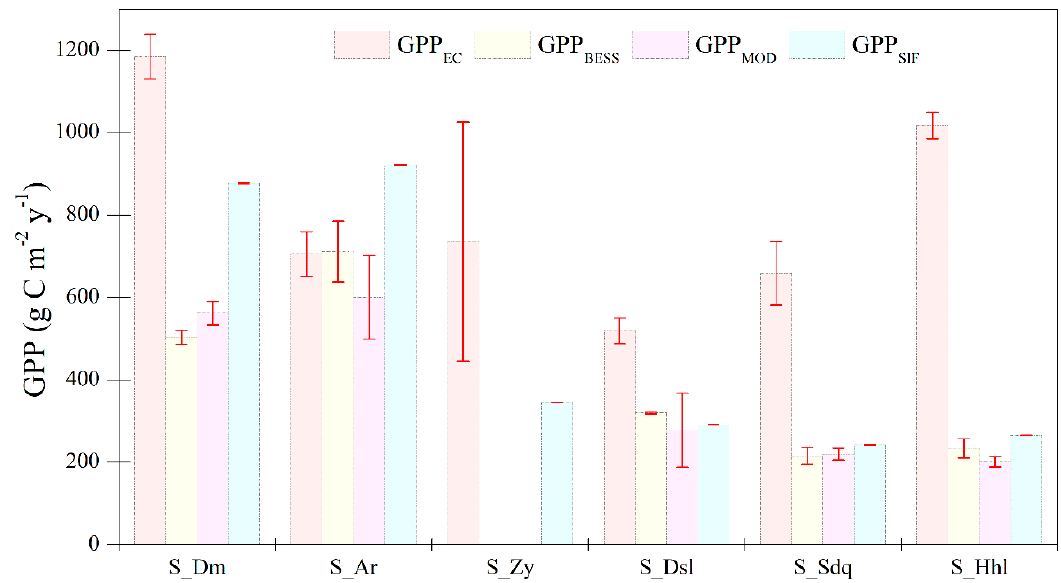
Figure 6. Comparisons of annual mean GPP observations (GPP EC ) and the remotely-derived products (GPP BESS , GPP MOD , and GPP SIF ) at the six flux sites between 2014 and 2015. Note: The values of both GPP MOD and GPP BESS were null at the S_Zy.